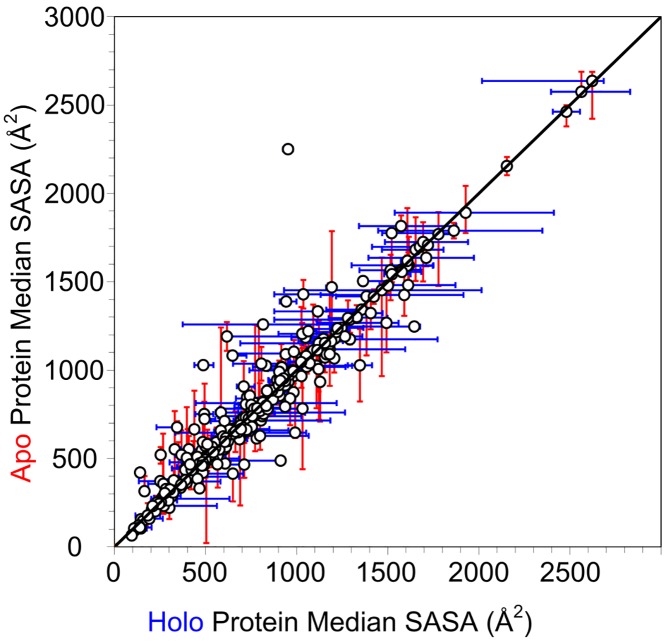
Median solvent accessible surface area of unified binding-site residues: Apo structures vs. holo structures.Error bars represent the minimum and maximum SASA value in each family for each structure type. The outlier is adenylate kinase, which exhibits significant domain motions upon ligand binding.